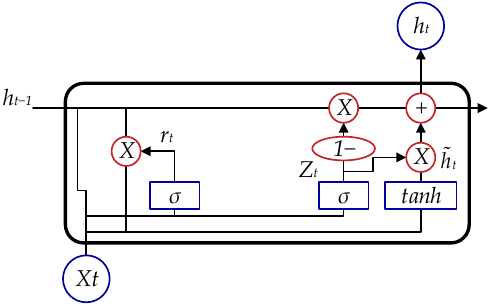
Figure 6. GRU architecture schematic.